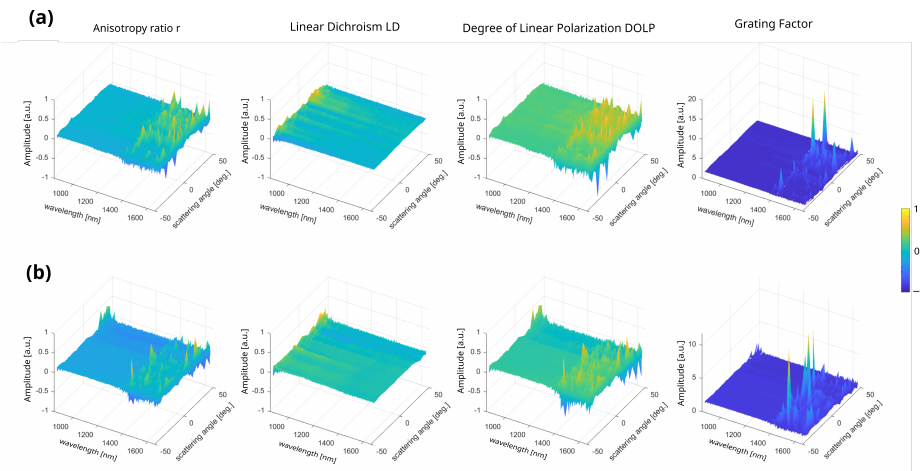
Figure 6. Multidimensional representation of the four averaged parameters studied in this work ( a ) over the connective/muscular ROIs and ( b ) over the tendon ROIs. The parameters r , LD , DOLP , and G correspond to the anisotropy ratio, the linear dichroism, the degree of linear polarization, and the grating factor, respectively.